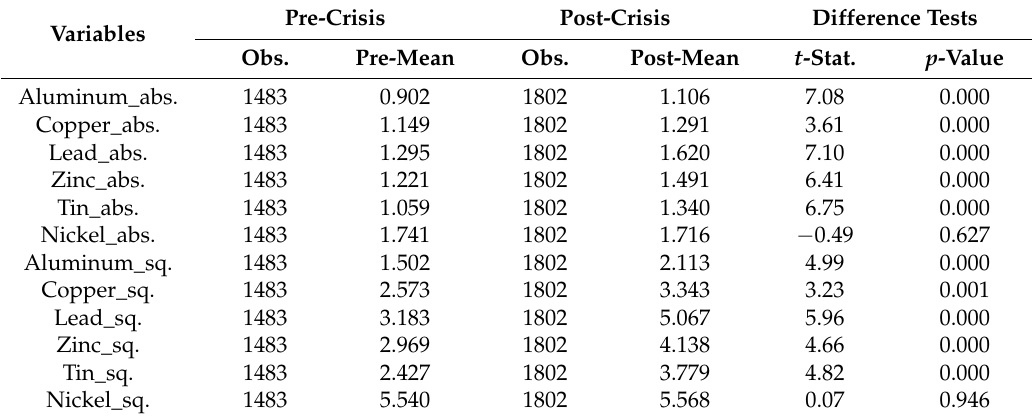
Table 3. Difference tests of daily volatilities for pre-crisis (2000–2008) vs. post-crisis (2009–June